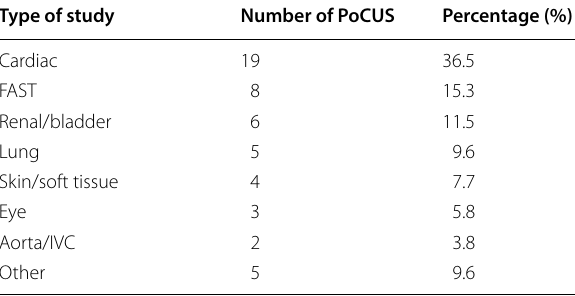
Table 1 The number and type of PoCUS